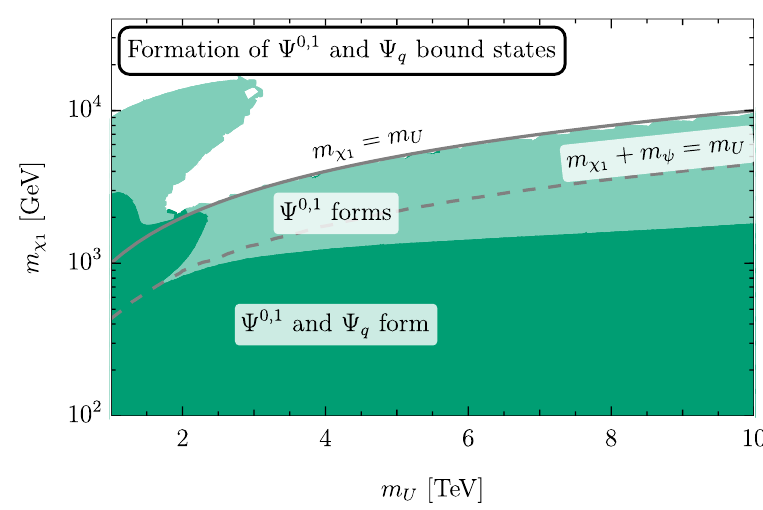
Figure 2 . Regions of the m χ − m U plane where ψ hadronizes, with ∆ ψ fixed to yield the observed 1 dark matter relic abundance. In the light green region the lifetime of ψ is long enough for ‘psionium’ states ( ψ ¯ ψ ) to form, while in the dark green region formation of ‘open-psi’ mesons ( ψ ¯ q ) also